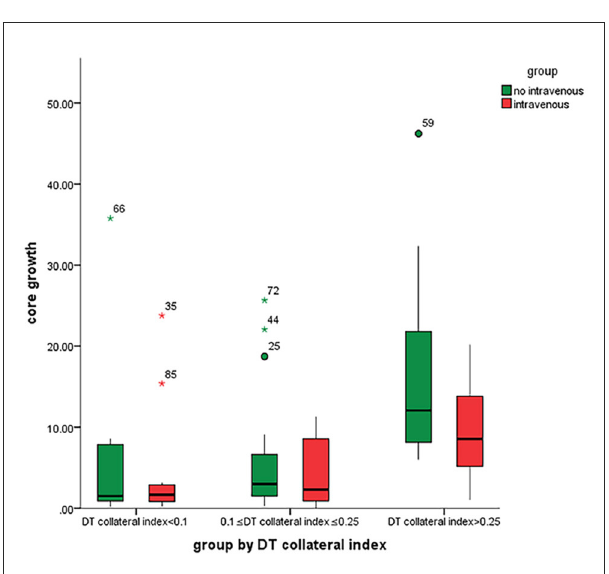
FIGURE4 Differences in the core growth rate between within the IVT (or not) group and within a DT collateral index group. IVT significantly decreased the core growth rate in patients with poor collateral